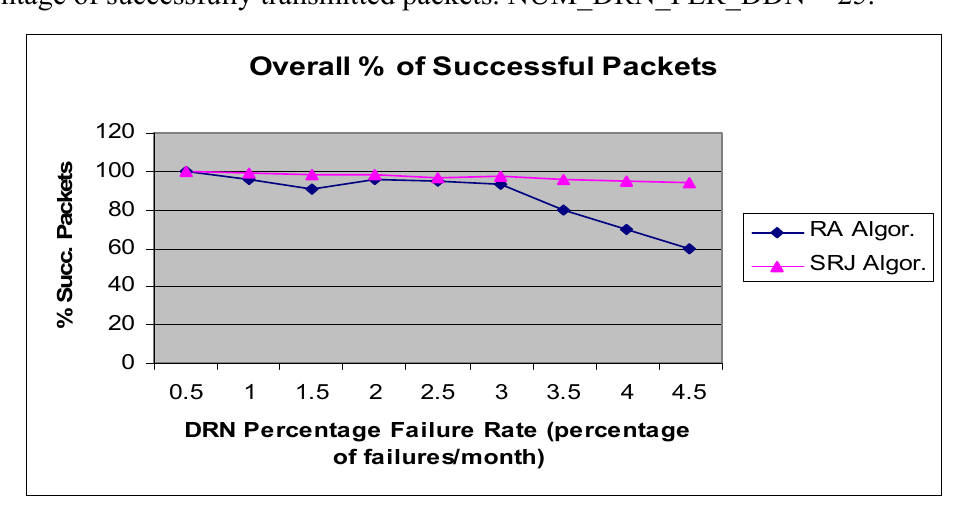
Figure 11. Simulation results for the hierarchical acoustic wireless sensor network. Percentage of successfully transmitted packets. NUM_DRN_PER_DDN = 25.